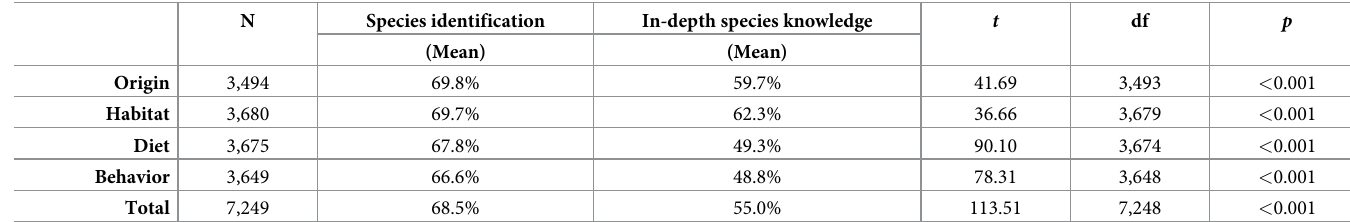
Table 1. Paired t -tests comparing average levels of two components of species literacy: Species identification and in-depth knowledge about species (subdivided into four themes). Each respondent was tested on two themes. N